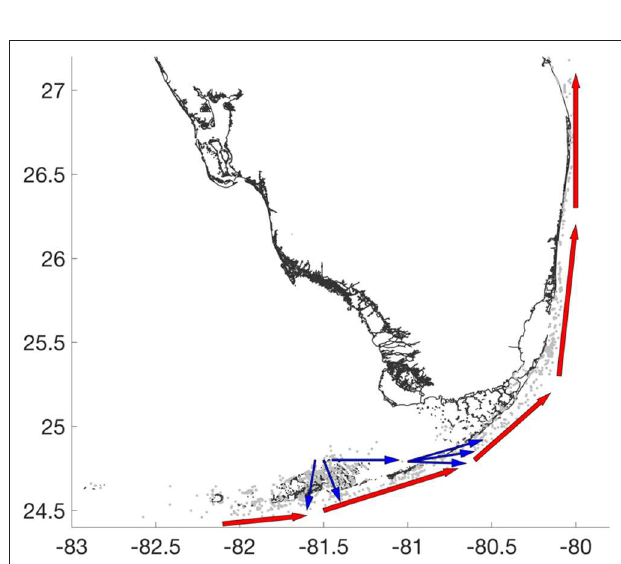
FIGURE 9 | Illustration of the two main connectivity pathways identified by our model. The outershelf pathway (red arrows) acts as a conveyor belt driven by the FC that connects most of the reefs from the South to the North. The Lower Keys pathway (blue arrows) connects the inner shelf reefs to the outer shelf by passing through the Lower and Middle